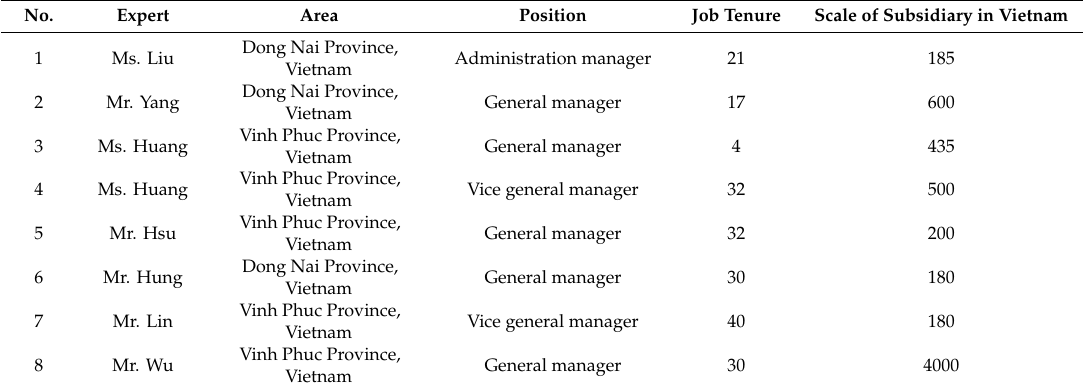
Table2. Basicinformation ofDANP(decisionmakingand trialevaluationlaboratory(DEMATEL)-based analytic network process) DANP industrial